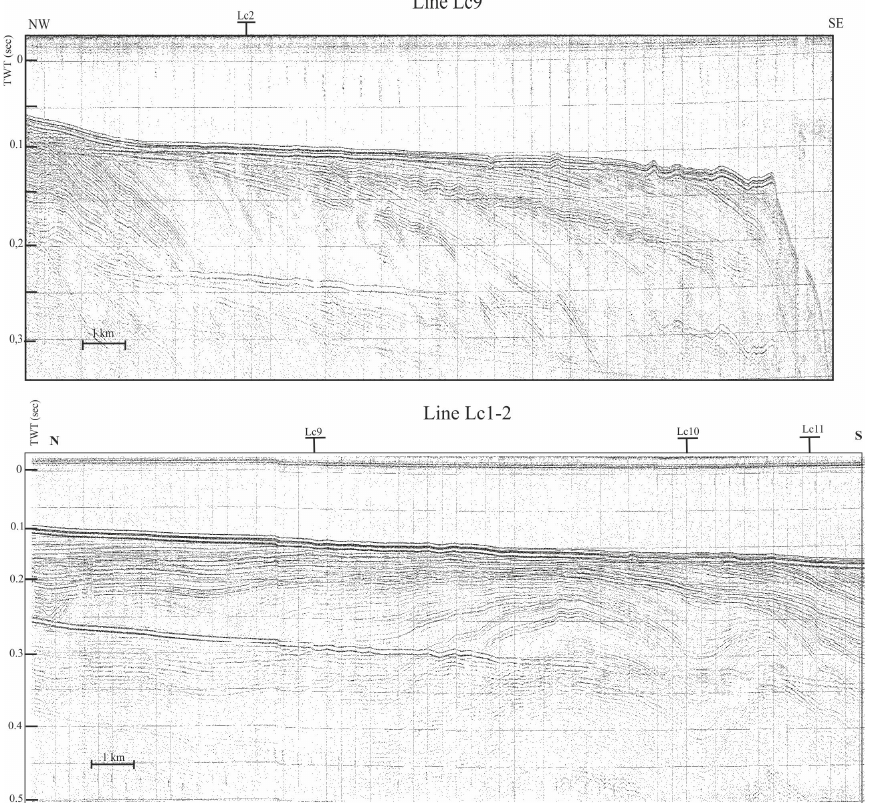
Figure 5. Sparker 1 kJ seismic profiles LC9 and LC1-2 (see Figure 2 for location) showing the regional stratigraphic architecture of the Salento continental shelf and the compressional deformations involving the area.